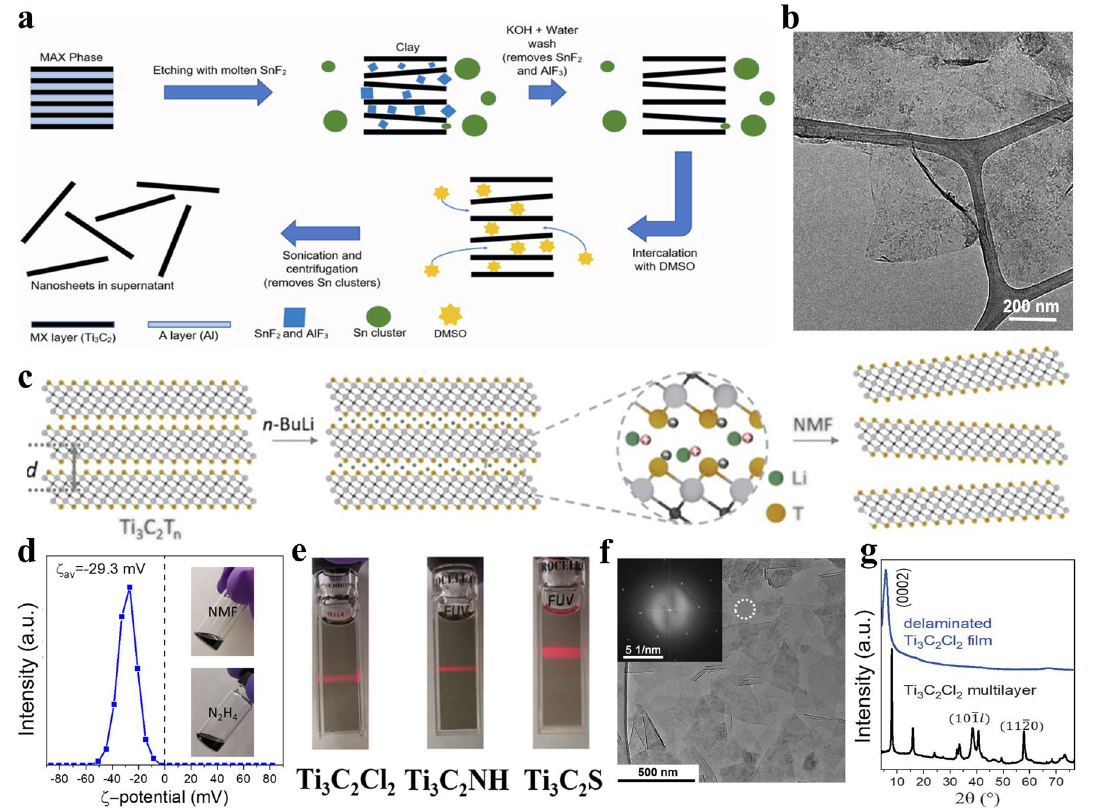
Fig. 9 a Schematic of the synthesis of KOH-treated few-layered Ti 3 C 2 T x MXene nanosheets. b Transmission electron microscope (TEM) image of Ti 3 C 2 T x nanosheets. Reproduced with permission from [154] Copyright 2021, The Authors. c Schematic of the intercalation and delamina- tion process. d Zeta potential of Ti 3 C 2 Cl 2 MXene in NMF and inset representing the high concentrated MXene inks in NMF and N 2 H 4 . e Digital photographs of stable colloidal solutions of Ti 3 C 2 T x MXenes (T = –Cl, –NH and –S) in NMF showing Tyndall effect. f TEM image of Ti 3 C 2 Cl 2 MXene nanosheets and inset showing its selected area electron diffraction (SAED) pattern. g XRD patterns of multi-layered and delaminated